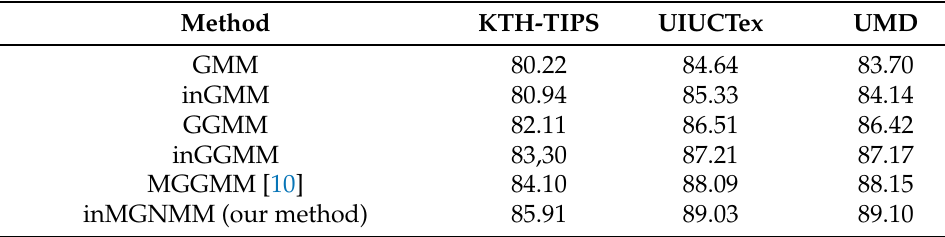
Table 1. Overall classification accuracy rate (%) of different approaches for the three texture datasets using SIFT features.